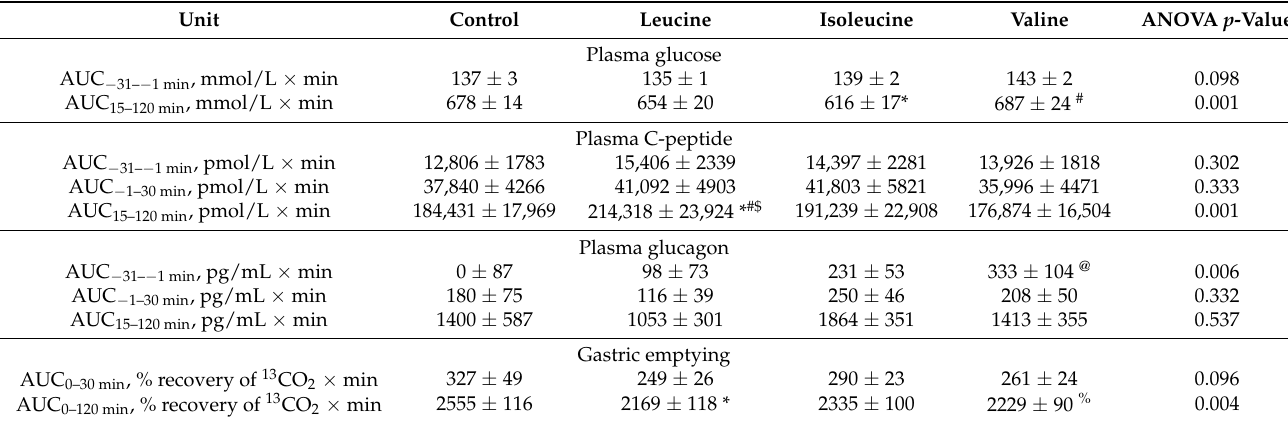
Table 1. Effects of intragastric administration of the branched-chain amino acids, leucine, isoleucine or valine, or control on plasma glucose, C-peptide and glucagon concentrations and gastric emptying 1